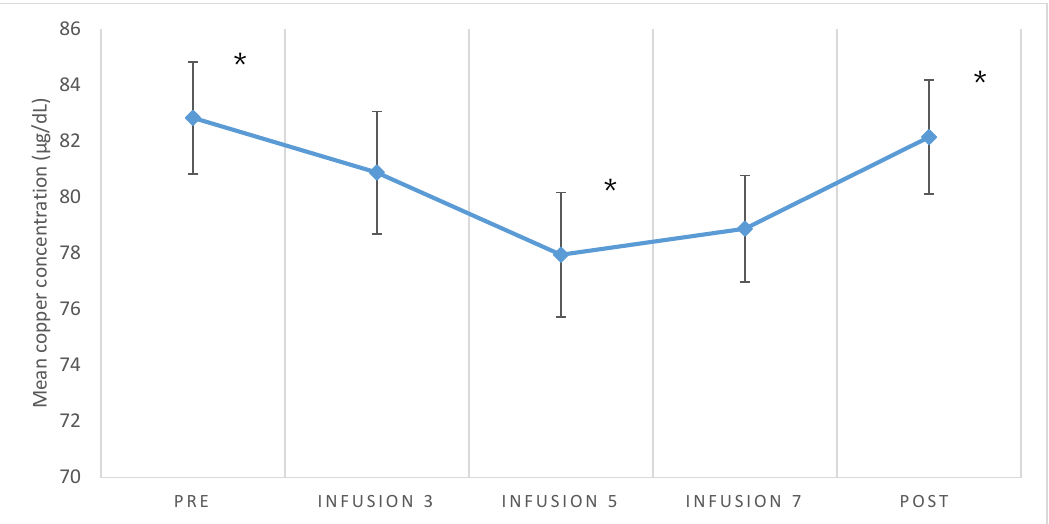
707274767880828486 Figure 1. Mean values and standard errors of the mean values for the concentration of serum copper ions in individual measurements; * the concentration of serum copper in the pre-treatment measurement was significantly higher than that after the fifth infusion ( p = 0.016), and the concentration after the treatment was significantly higher than that after the fifth infusion ( p = 0.048). Figure 2. Mean values and standard errors for changes in copper serum levels among responders, remitters, and non-responders. The concentration of copper during the course of treatment was not associated with somatic comorbidities (Table 2); however, we found that arterial hypertension was significantly more common in the group of responders, while diabetes mellitus occurred significantly more often in the group of remitters (Table 1).